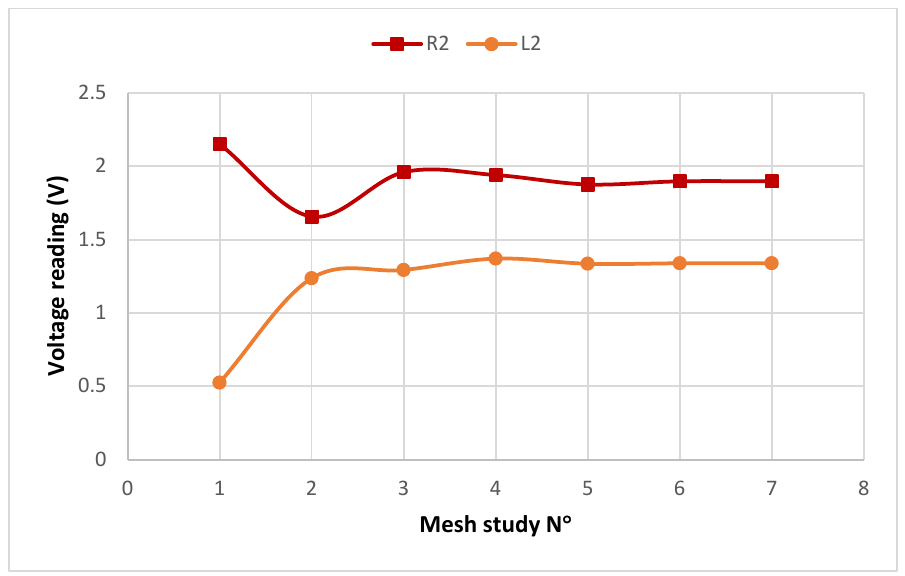
Figure 3. Voltage values measured by the sensors L2 and R2 for different studies.